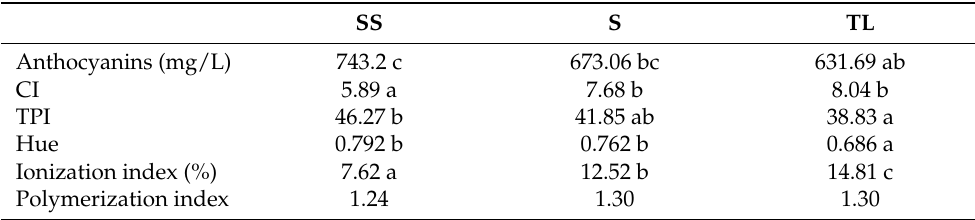
Table 2. Values of the parameters related to the color analyzed in the wines (SS: spontaneous sulfite, S: spontaneous without SO 2 , TL: inoculation with T. delbrueckii / L. thermotolerans at vatting without SO 2 ). SS S TL Anthocyanins